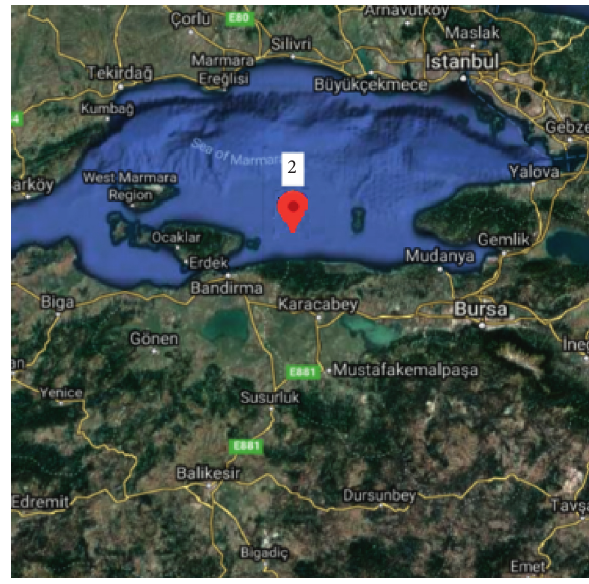
Figure 3: Sample collection from Bandırma Coast of Marmara Sea (40 ° 53 ′ N, 28 ° 25 ′